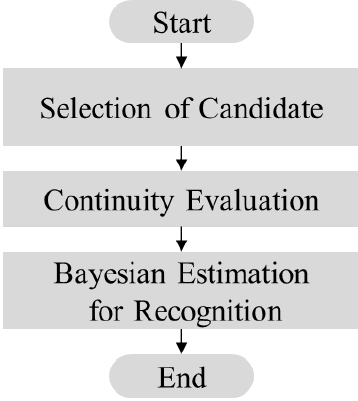
Figure 2. Proposed framework of probability-based recognition.